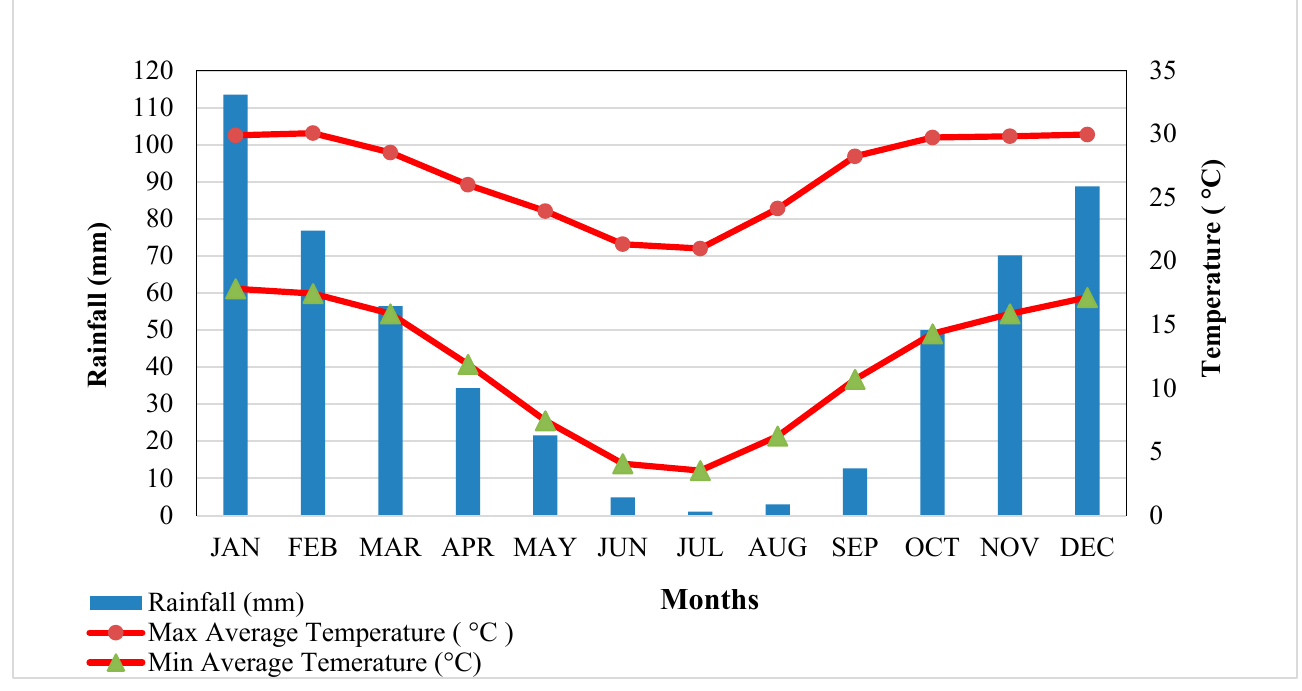
Figure 3. Rainfall and temperature averages for Rustenburg (1993–2016).